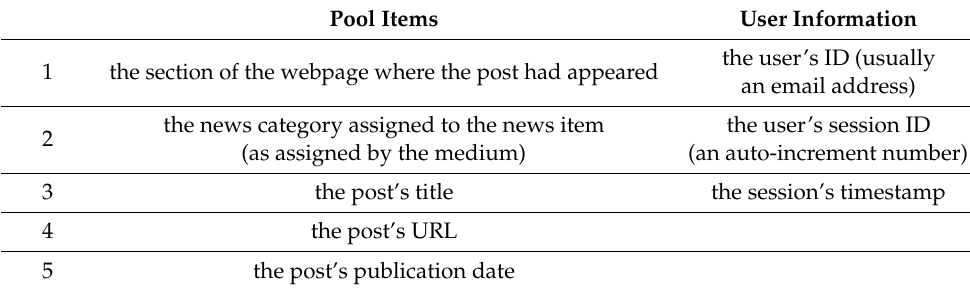
Table 2. Additional data collected pertaining to ‘pool items’ and user information. Pool Items User